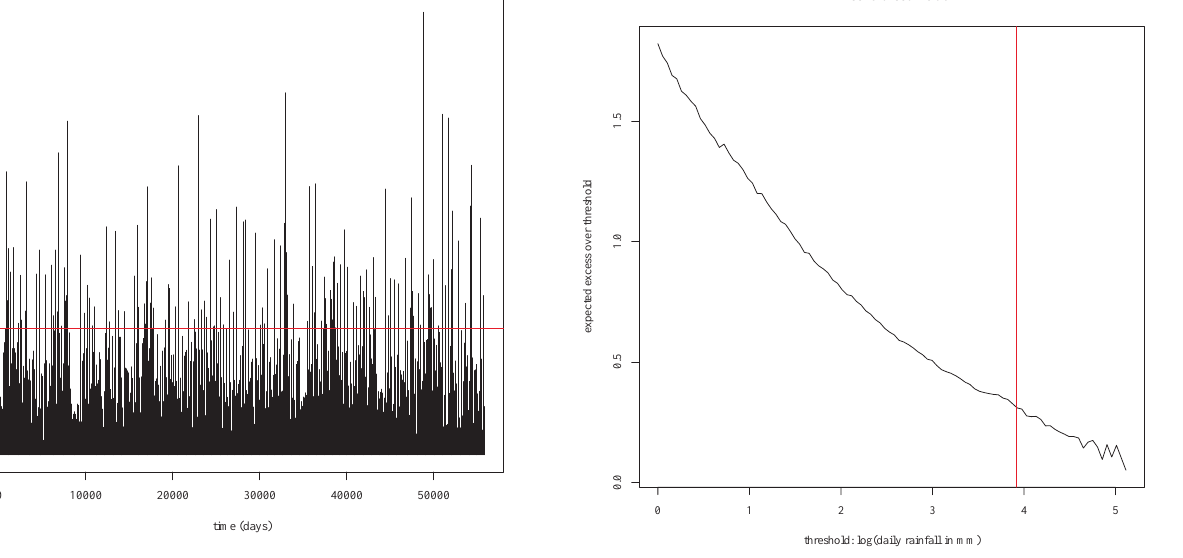
Fig. 2. Graphical estimation of log-daily-rainfall reference thresh- old: exp ( 3 . 9 ) ≈